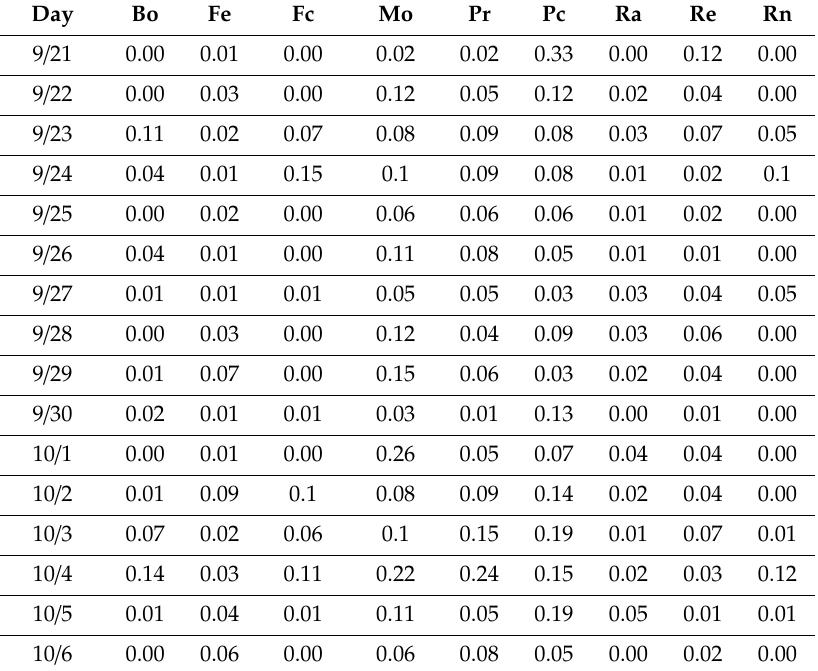
Table 4. Predictions (2017-2018-2019- > 2020): probability